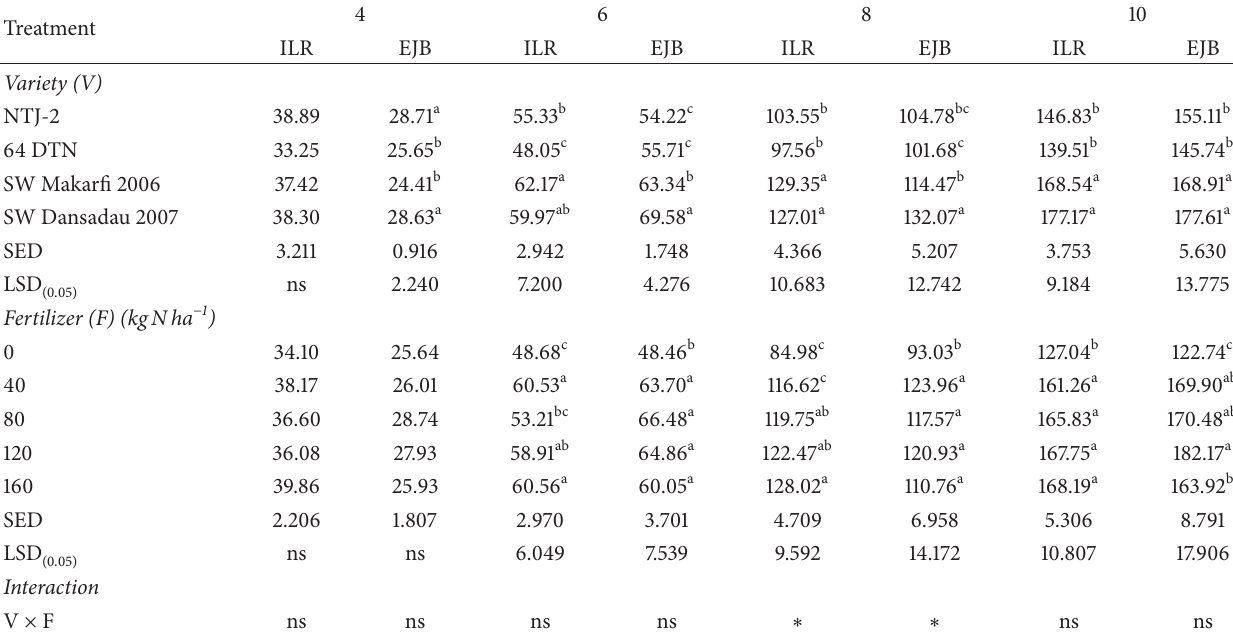
Table 2: Main effects of variety and 𝑁 fertilizer on the plant heights (cm) of sweet sorghum at 4 to 10 weeks after sowing (WAS) at the Ilorin (ILR) and Ejiba (EJB) experimental